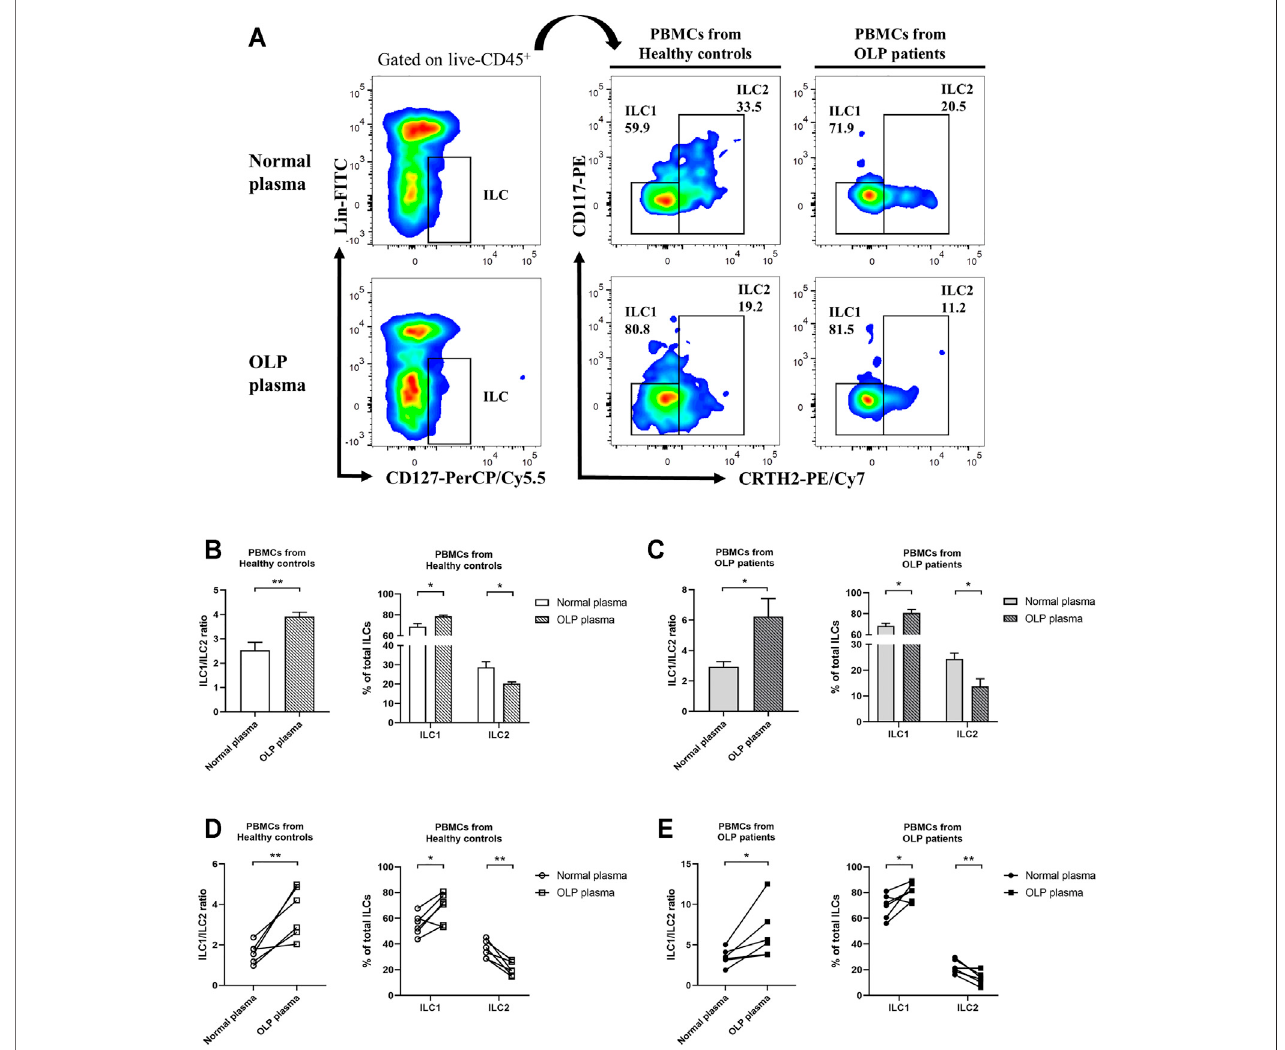
FIGURE 6 | In vitro plasma stimulation test. PBMCs from healthy controls and OLP patients were stimulated with OLP plasma or normal plasma for 3 days. (A) Gating strategy identifying ILC1sand ILC2s.The ILC1and ILC2 proportions intotal ILCsaswell asILC1/ILC2ratiowere presented: PBMCs fromahealthyindividual (B) oranOLPpatient (C) werestimulatedwithdifferentOLPplasmaornormalplasmaseparatelyfor3 days.PBMCsfromdifferenthealthyindividuals (D) orOLPpatients (E) werestimulatedwithmixedOLPplasmaormixednormalplasmaseparatelyfor3 days.Dataaredepictedinbefore – afterplotsorasabargraphwithmean ± SEM. Two-tailedunpairedMann – Whitneytestsandpairedt-testswereperformed,* p < 0.05,** p < 0.01.PBMCs,peripheralbloodmononuclearcells;OLP,orallichenplanus.